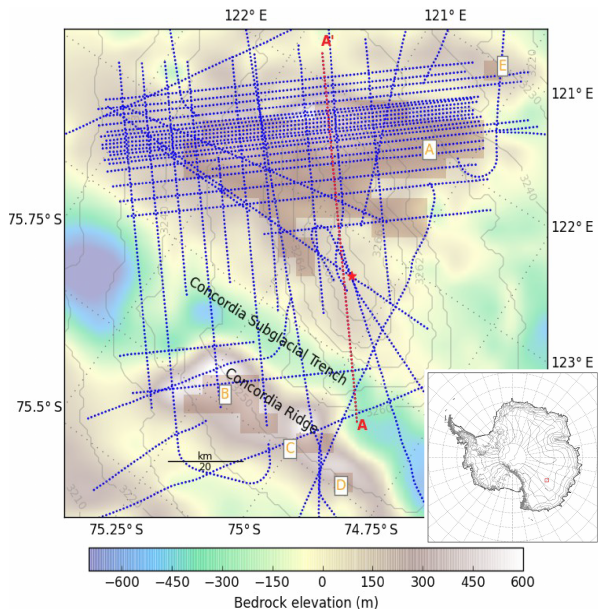
Figure 1. Radar transects used in this study (dotted blue and red lines). The light colour scale represents the bedrock elevation (Fretwell et al., 2013) while the thin grey transparent lines represent the surface elevation (Fretwell et al., 2013). The red square in the in- set show the location of the zoomed map around EDC. The red star is the location of the EDC drilling site. The orange squared areas are oldest-ice candidates from Van Liefferinge and Pattyn (2013). The red dotted line is the OIA/JKB2n/X45 radar line displayed in Fig. 3.